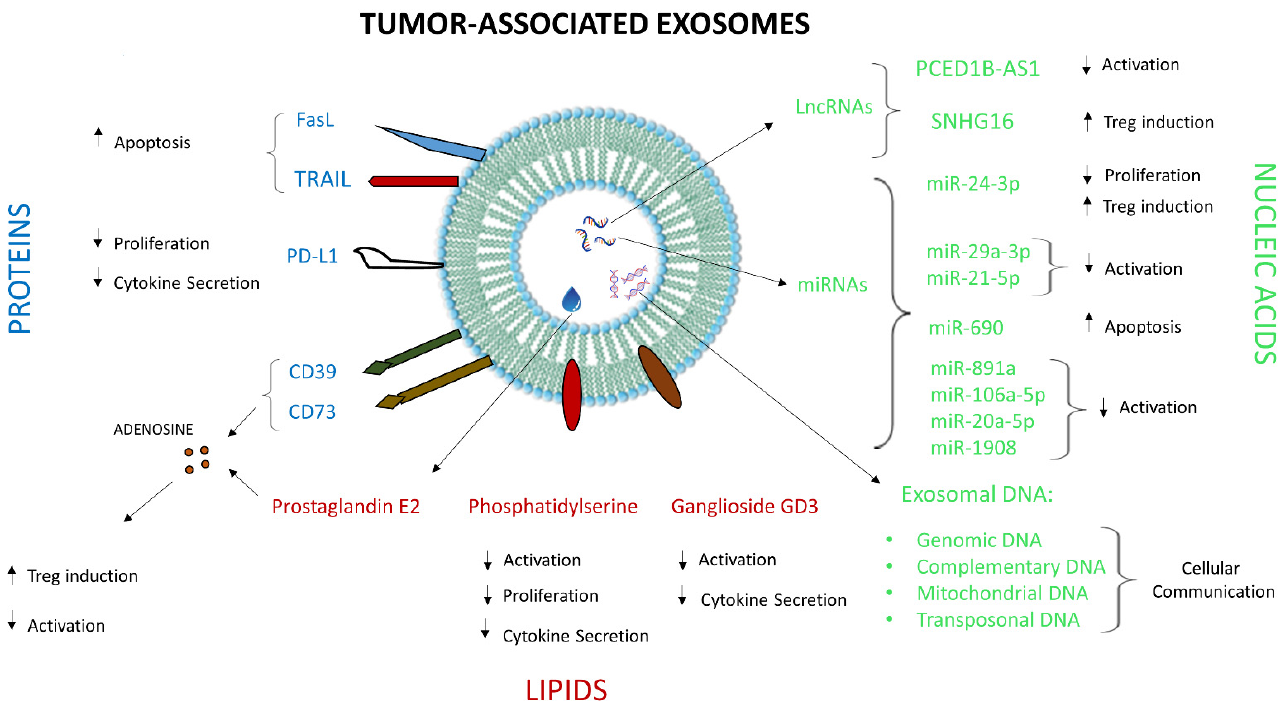
Figure 2. Immunosuppressive molecules associated with tumor exosomes and their effects on human T cells. Different proteins (blue text), lipids (red text) and nucleic acids (green text) and their effects on T cell activation, proliferation, cytokine secretion and other functions are depicted.